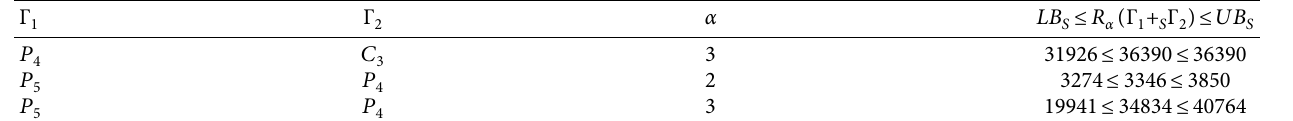
Table 3: Few more cases of lower and upper bounds regarding R